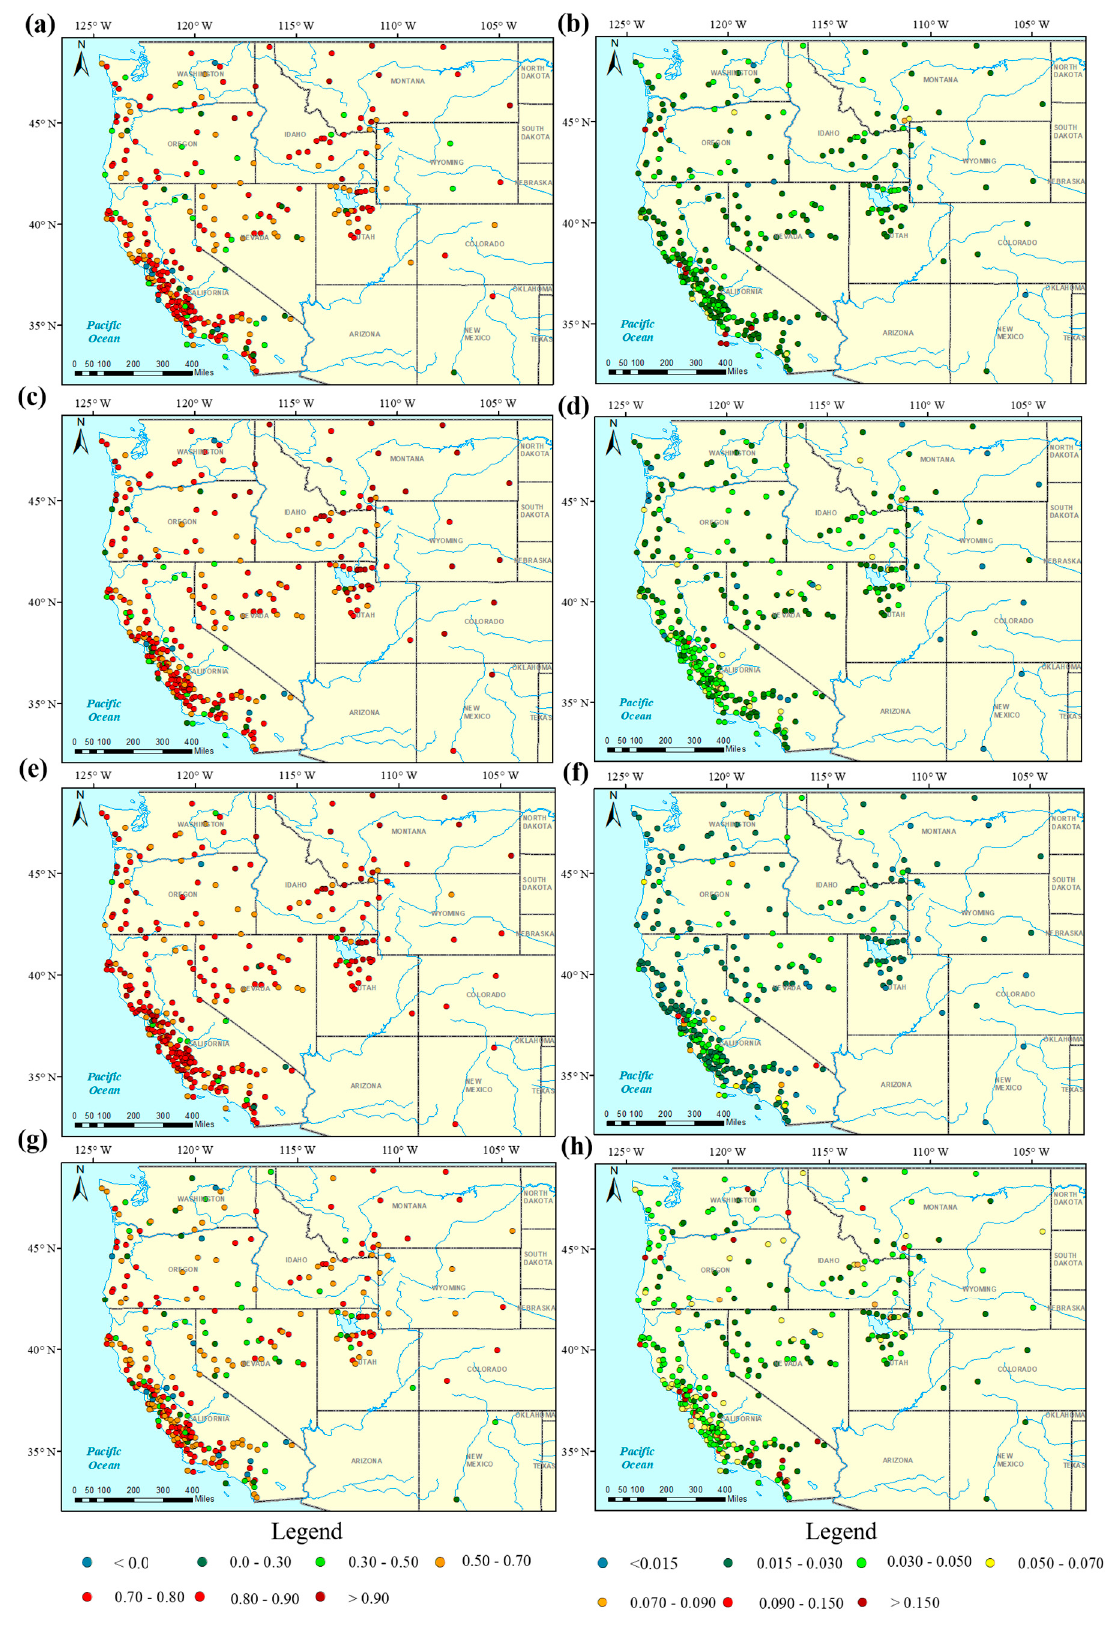
Figure 8. Spatial distribution of R and RMSE between the observed and estimated NMRI over the PBO H2O sites for the four models: ( a ) BPNN-R; ( b ) BPNN-RMSE; ( c ) GRNN-R; ( d ) GRNN-RMSE; ( e )